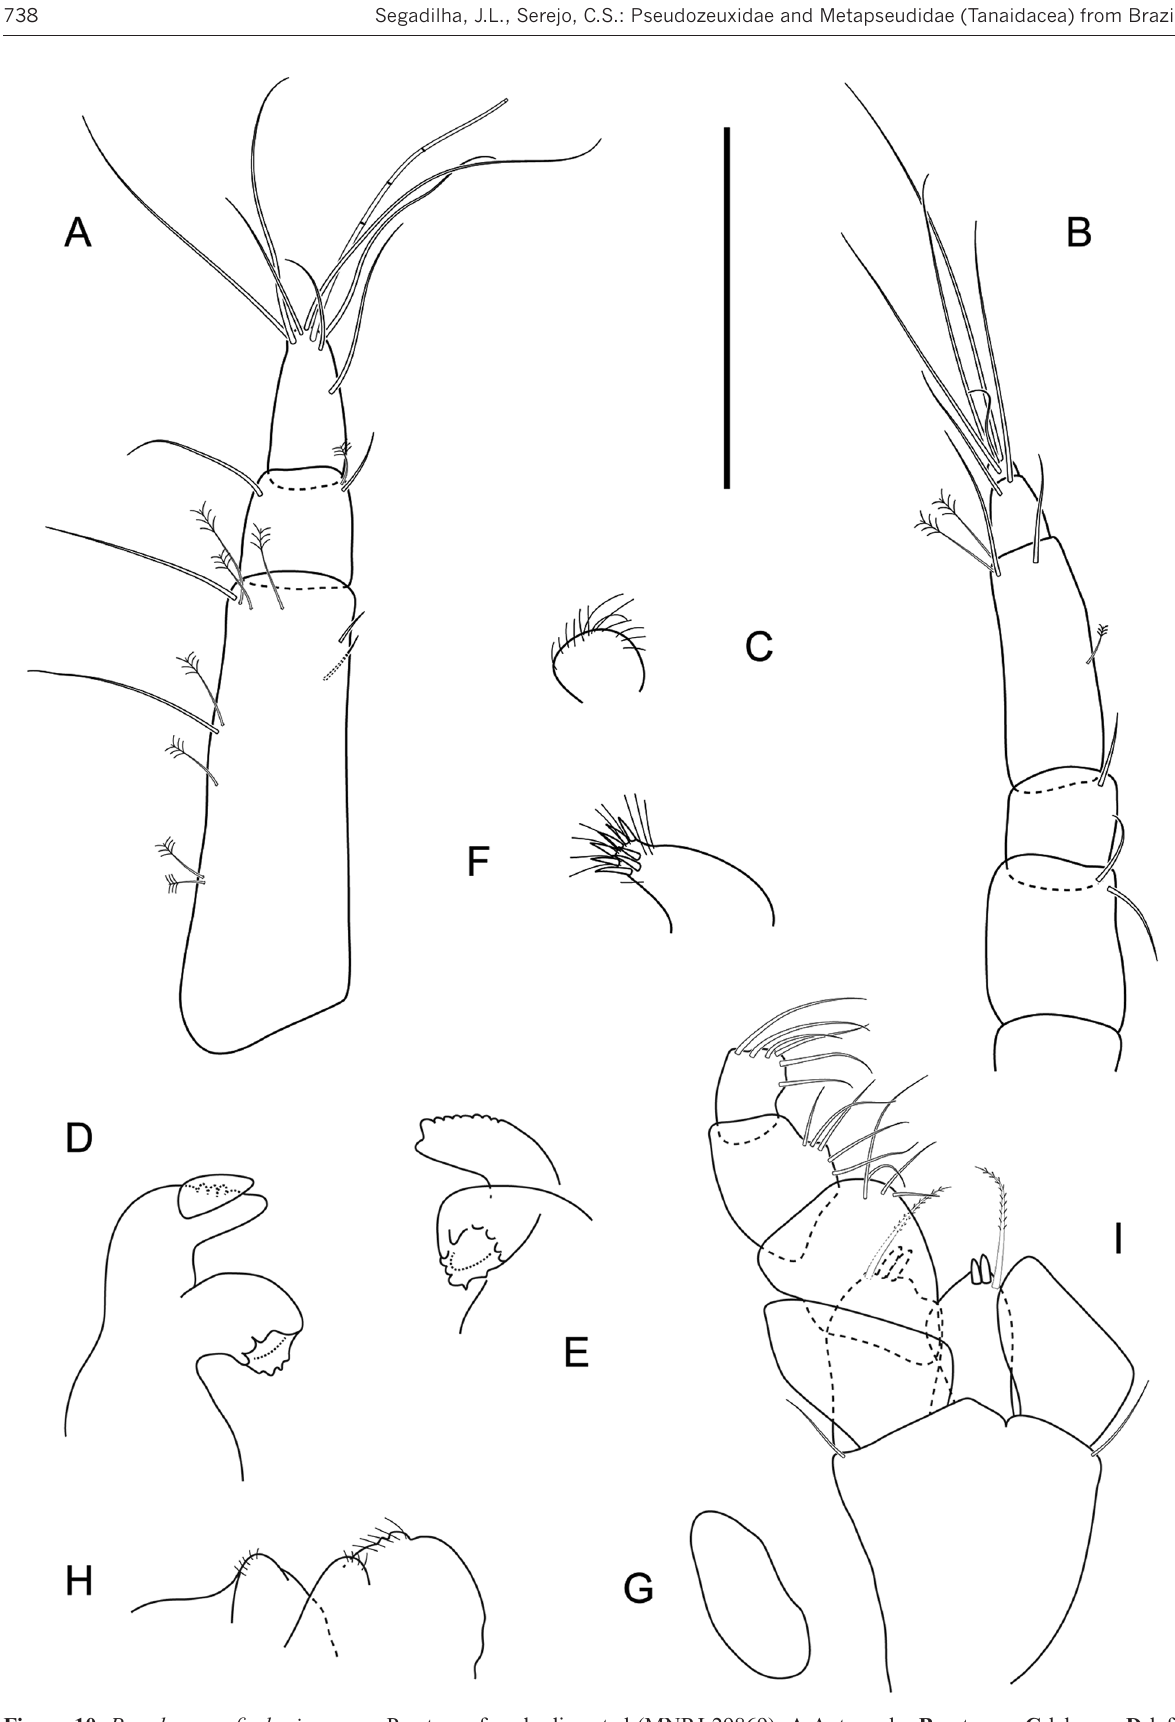
Figure 10. Pseudozeuxo fischeri sp. nov. Paratype, female dissected (MNRJ 29869). A Antennule; B antenna; C labrum; D left mandible; E right mandible; F maxillule; G maxilla; H labium; I maxilliped. Scale bar: 0.1